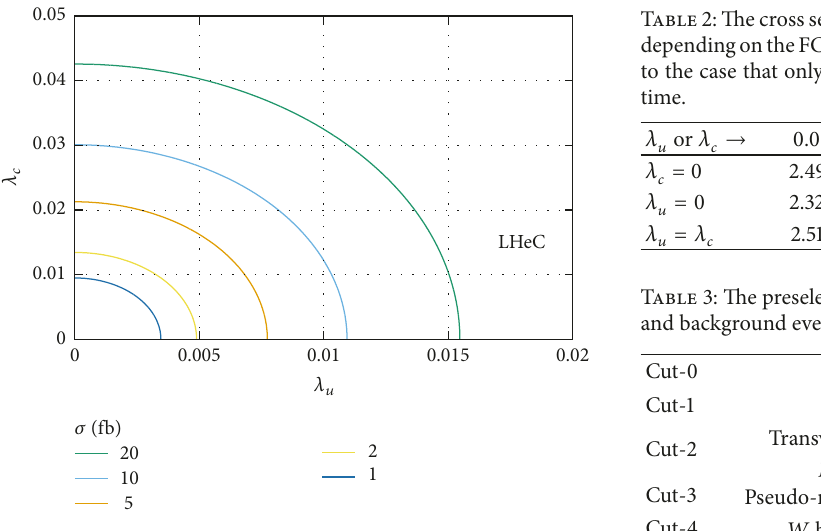
Figure 2: Contour plot for plane of FCNC couplings 𝜆 𝑢 and 𝜆 𝑐 depending on signal cross sections at LHeC.